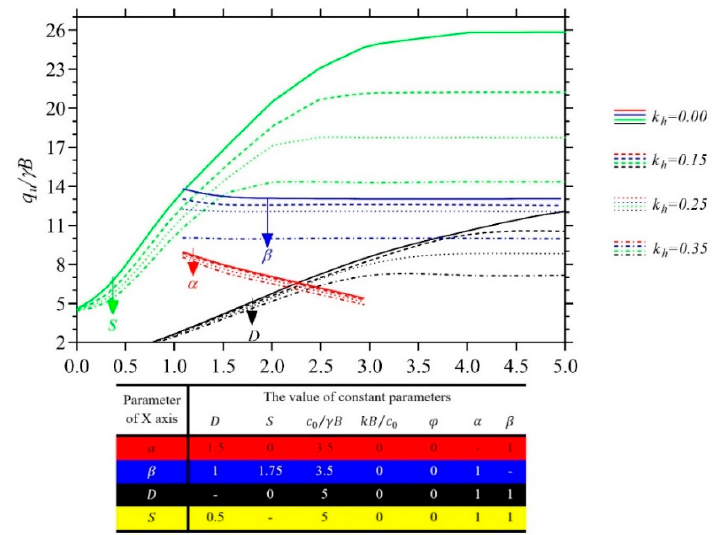
Figure 5. Parametric analysis: effects on the bearing capacity Q = q u / γ B under different values of the seismic acceleration coefficient k h , of the dimensionless void parameters α (red plots), β (blue plots), S (green plots), and D (black plots).